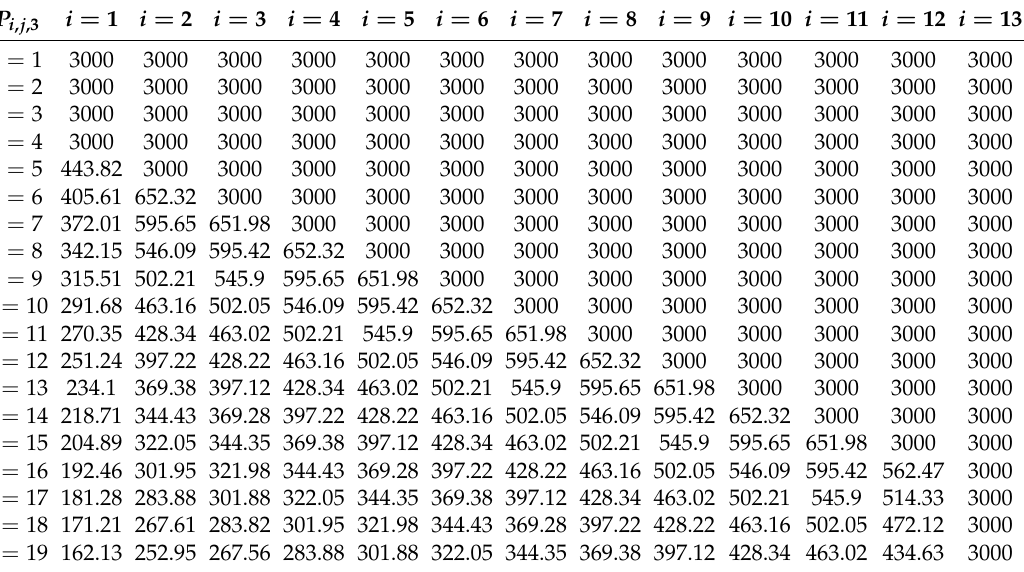
Table A7. Decay heat power of an assembly of OL3 belonging to the removal i ∈ I in the period j ∈ J P i , j ,3